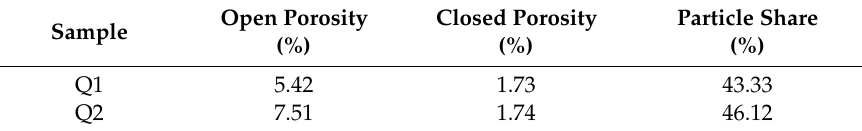
Table 5. Porosity and percentage of particles in the raw samples Q1 and Q2. Sample